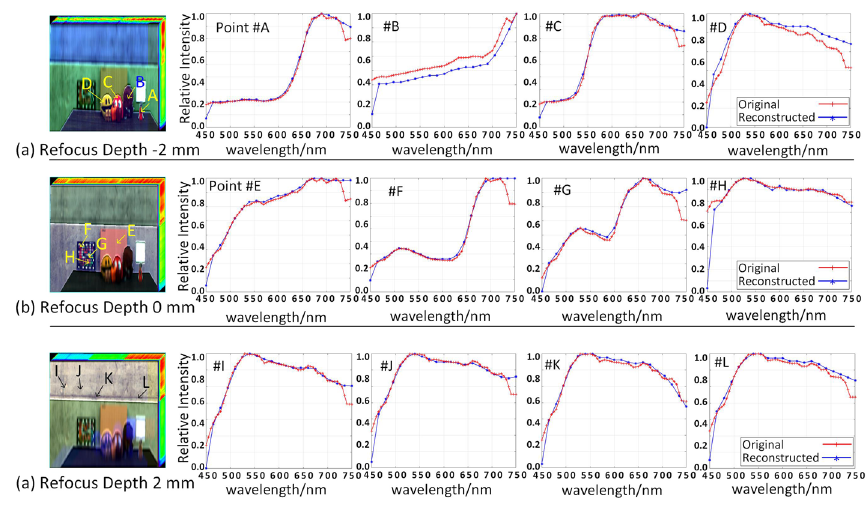
Fig. 9 The spectral curves of some representative points. ( a ), ( b ) and ( c ) are the reconstructed datacube and spectral curves at refocused depth 2 mm, 0 mm and 2 mm, respectively −